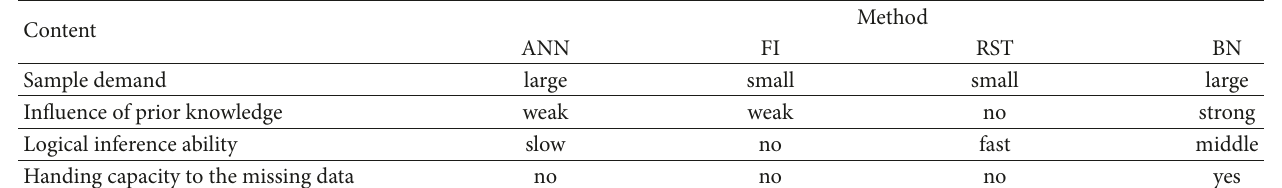
Table 1: The ability comparison of BN, FI, RST, and BN.